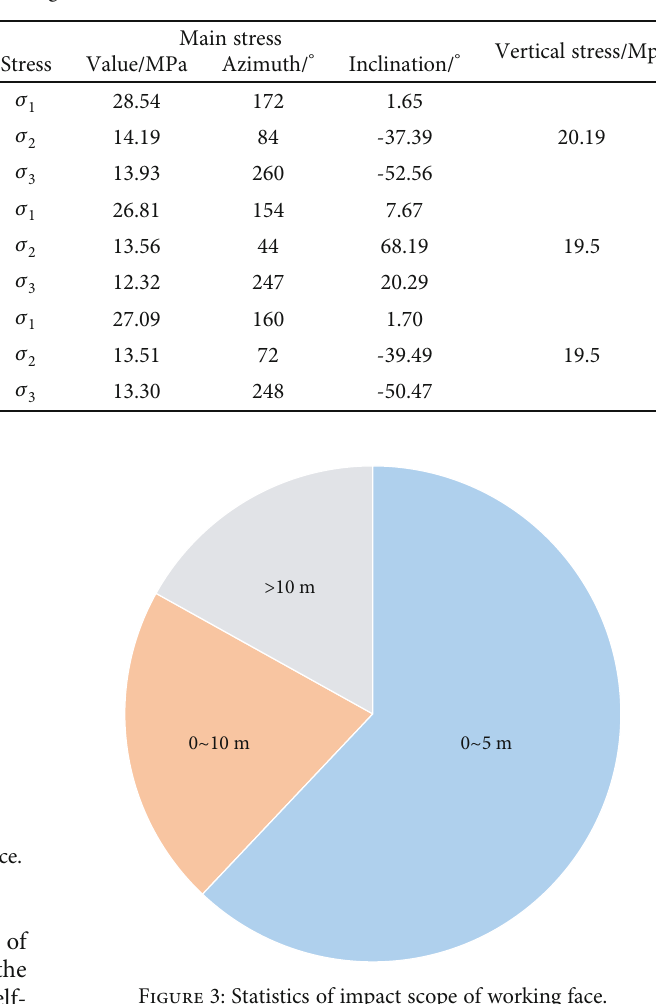
Table 4: Summary table of ground stress measurement.